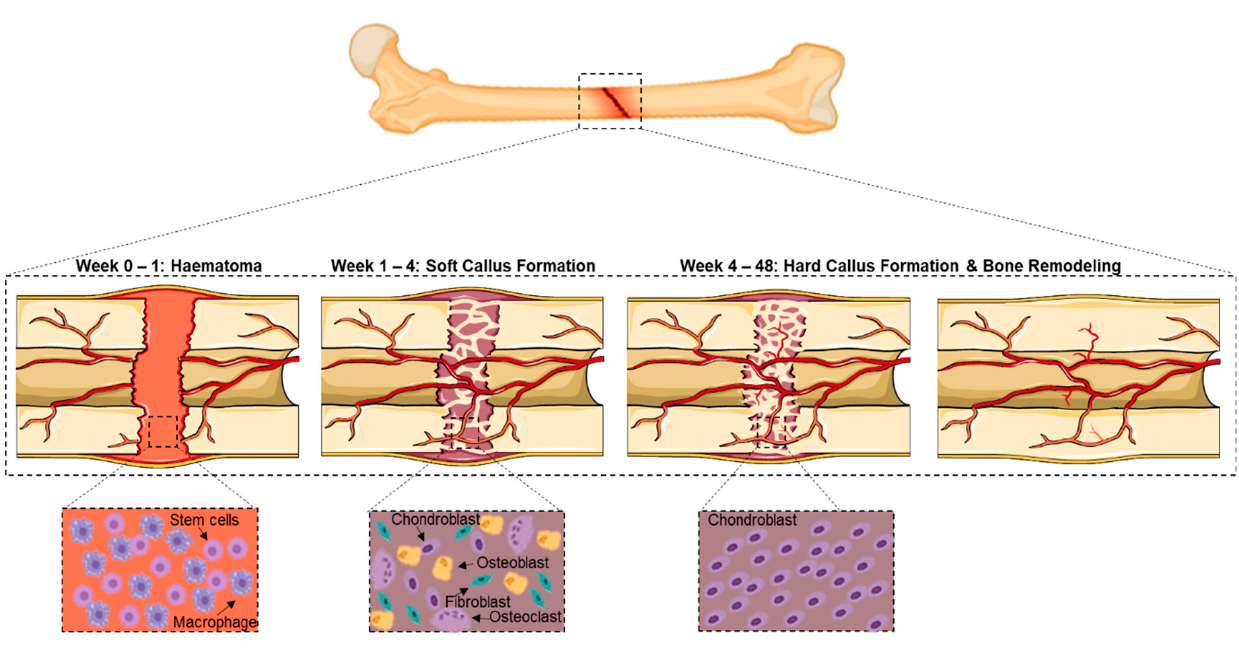
Figure 1. Stages of bone healing: (1) haematoma formation from stem and macrophage cells at the fracture site (week 0–1), (2) soft callus formation at the fracture site, from chondroblast, osteoblast, fibroblast and osteoclast, replaces the hematoma (week 1–4) and (3) hard callus replaces the soft callus, using chondroblast cells and, after week 6–8, bone starts to replace the hard callus (week 4–48).